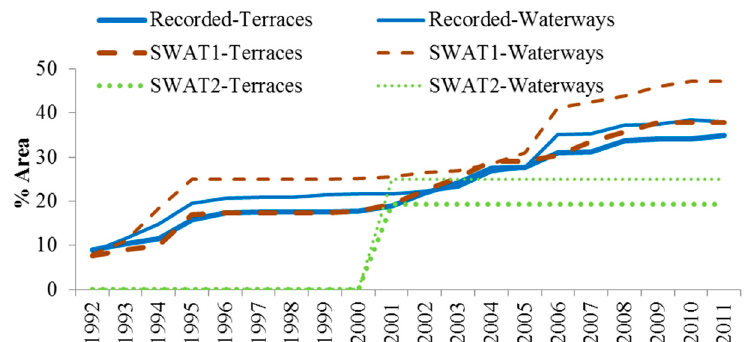
Figure 7. Input percentage areas of FDT and grassed waterways compared with records from 1992 to 2011 in the BBW.